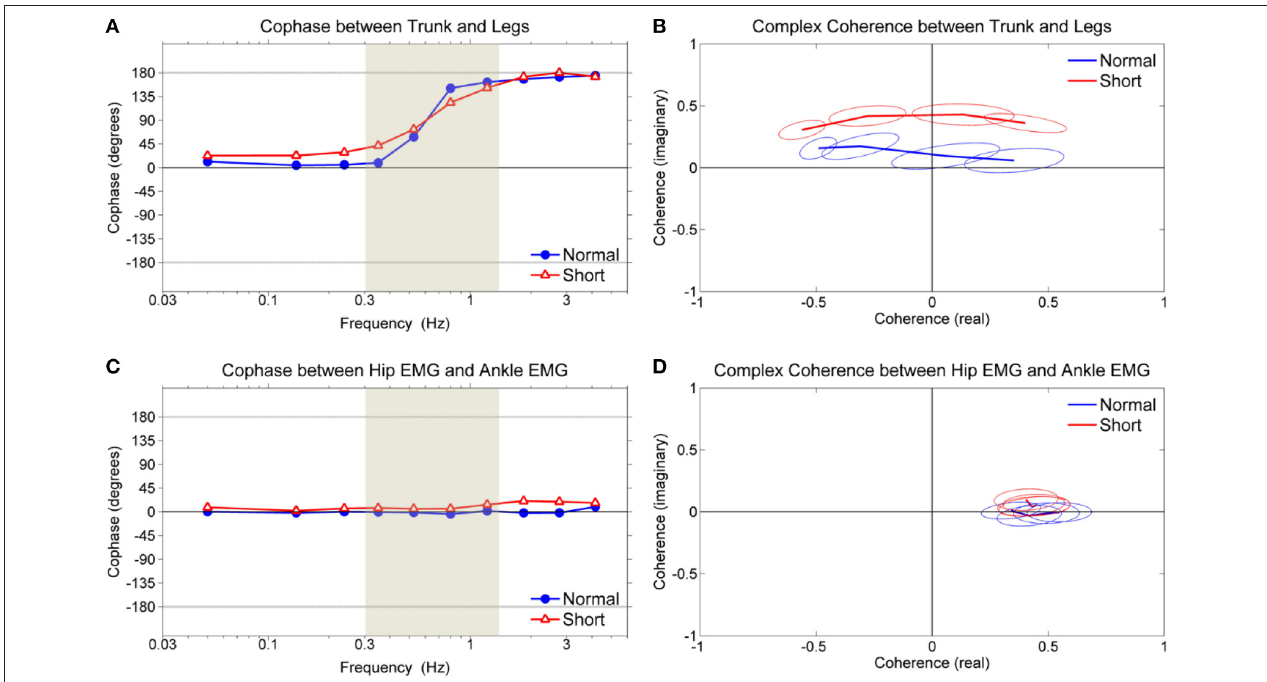
FIGURE 4 | Cophase and complex coherence. (A) Cophase between trunk and leg segments, (B) complex coherence of shaded region in (A) between trunk and leg segments, (C) cophase between weighted hip EMG and weighted ankle EMG, (D) complex coherence of shaded region in (C) between weighted hip EMG and weighted ankle EMG. Ellipses of complex plane represent 95% confidence region in the complex